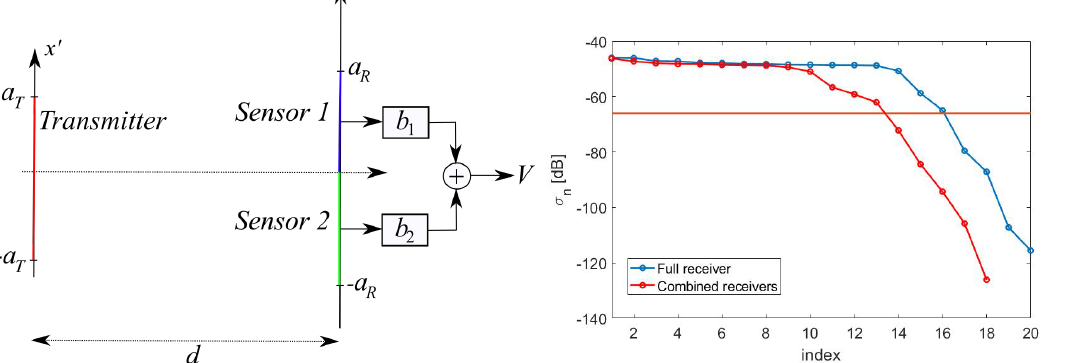
Figure 14. ( Left ): combining the “optimal” half-sensors with weights. ( Right ): SVB for the two half-sensors apertures combined with